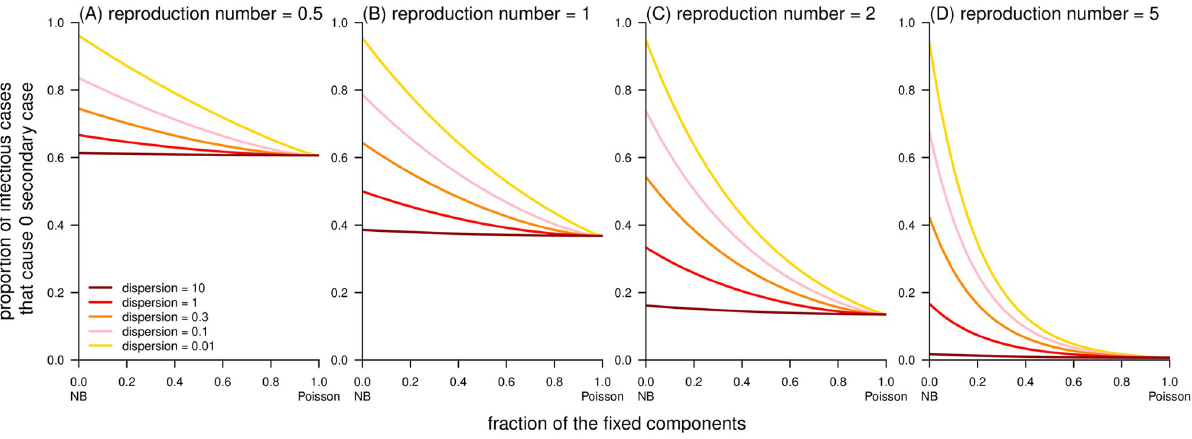
Fig 3. Simulation results of the proportion of cases, i.e., f D (0), that cause 0 secondary case as a function of fraction of fixed component ( ρ ) generated from Delaporte distributions. The ‘NB’ in the horizontal axis label stands for negative binomial (distribution).